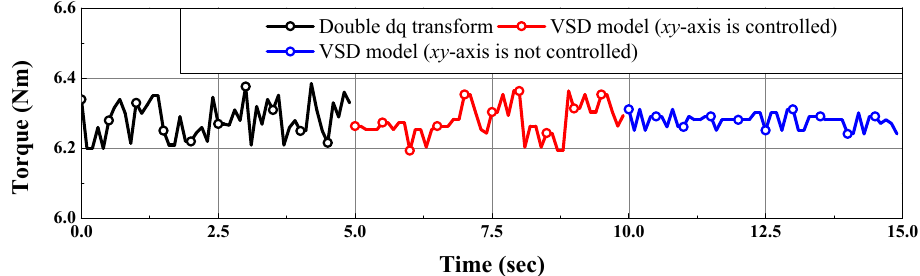
Figure 13. Torque profile of experimental results according to the coordinate transformation method in a single-phase open fault.